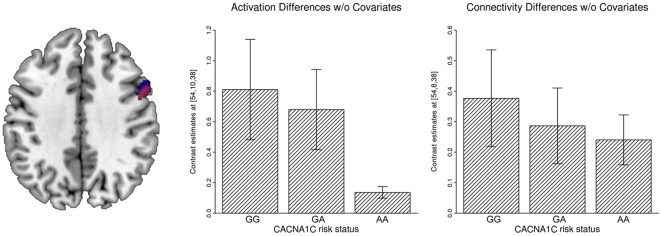
Influence of Seed Voxel Coordinates as Covariates on the Group Level.Reduction of genotype effects after entering seed-voxel localization as covariate on the second level. Left: A linear decrease in regional activation is found with number rs1006737 risk alleles in the right DLPFC (blue). A similar gene-dosage dependent effect in functional connectivity was found at the same location (red). After controlling for differences in the spatial distribution of seed-voxel localization with introduction of the MNI coordinates in the x-, y-, and z-dimension as covariate on the second level the associations of genotype with DLPFC connectivity was reduced and non-significant at p>.05 corrected